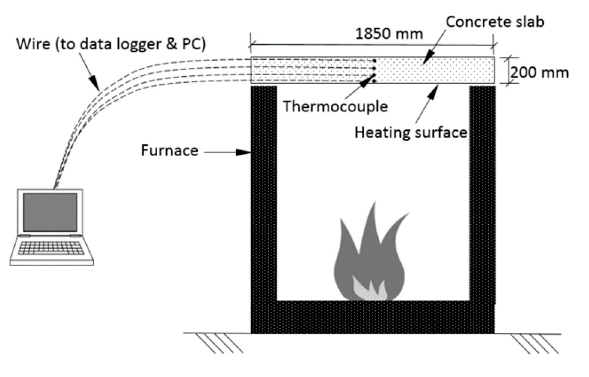
Figure 2. Fire test setup.